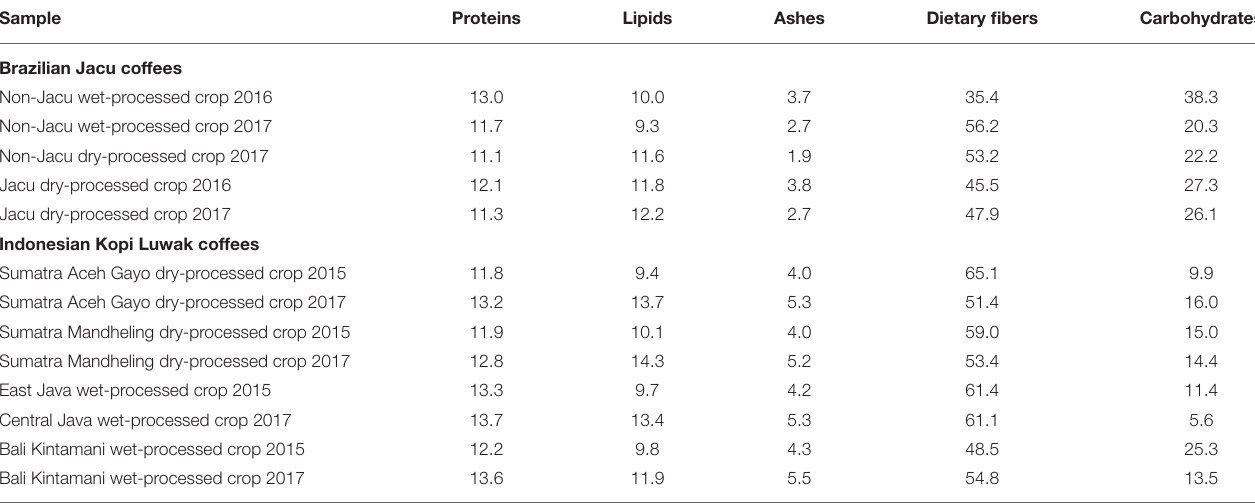
TABLE 2 | Proximate composition (g/100g dry weight) of non-Jacu, Jacu and Kopi Luwak coffee samples a . Sample Proteins Lipids Ashes Dietary fibers